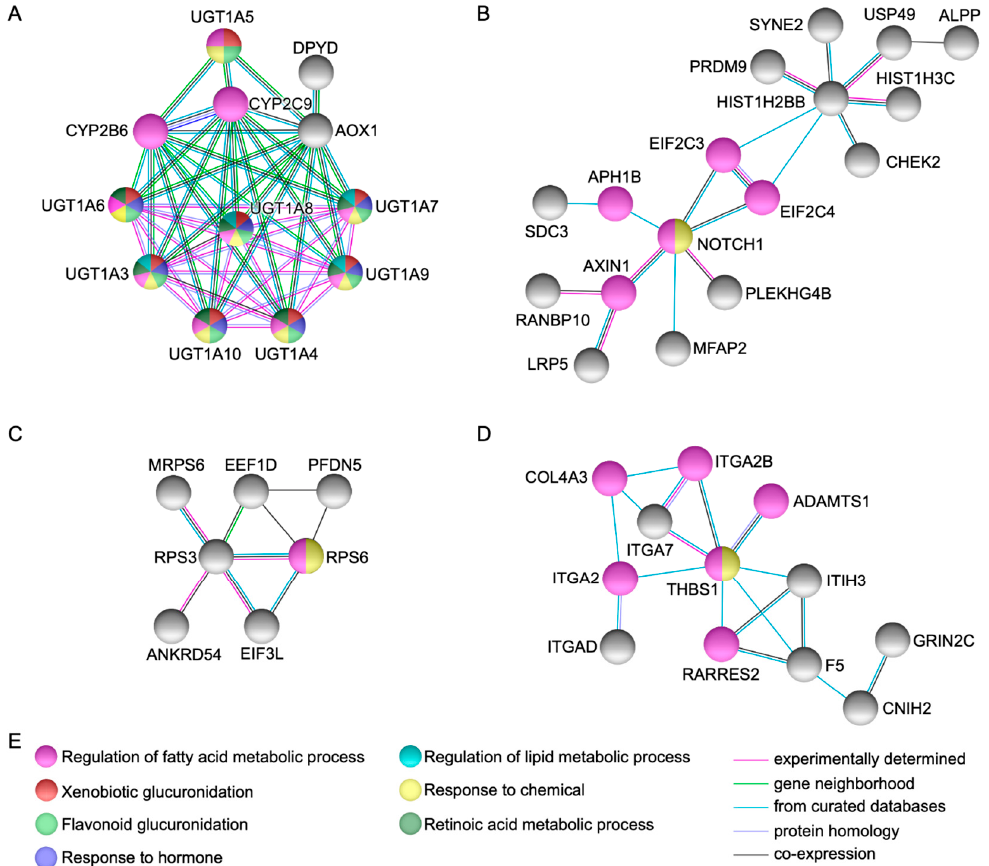
Figure 1. Network modeling from protein-protein interactions. The figures ( A )–( D ) show high connectivity and direct protein-protein interactions via several partners in genes UGT1A3 , UGT1A4 , THBS1 . Figure ( E ) depicts the biological processes identified in the